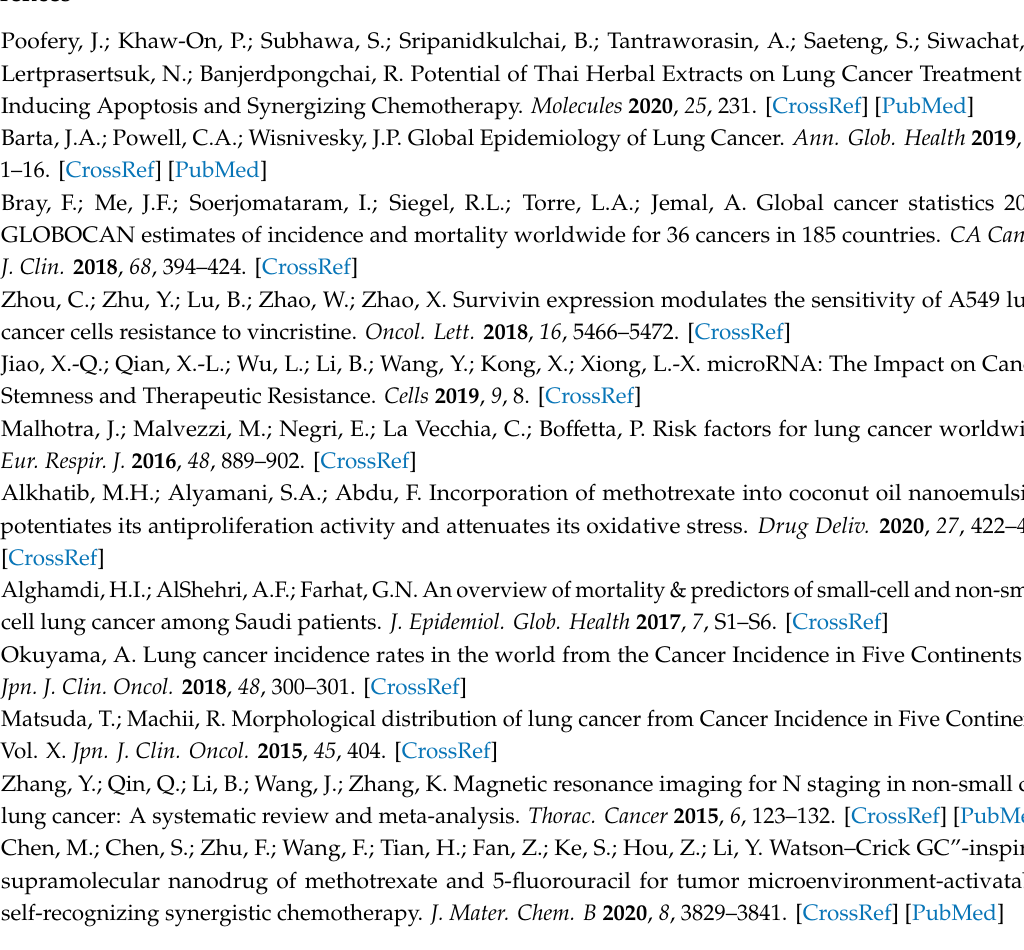
Figure S7: The interaction of the most promising compounds with Jak2 protein, (A) 3D interaction, (B) hydrogen bond formation, and (C) hydrophobic interaction, Figure S8: The interaction of the most promising compounds with DHFR protein, (A) 3D interaction, (B) hydrogen bond formation, and (C) hydrophobic